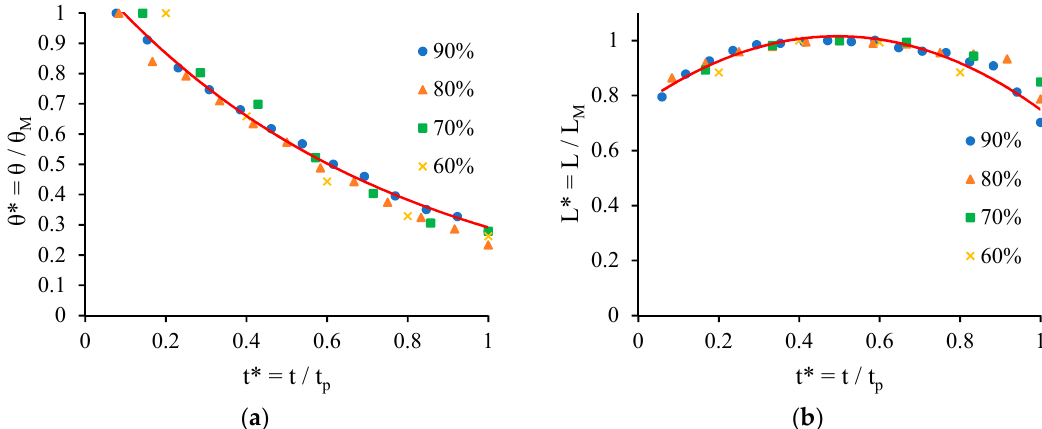
Figure 9. Contact angle ( a ) and droplet base diameter dimensionless ( b ) profiles for different percentage (%) concentrations of surfactants on dry audio sponge.